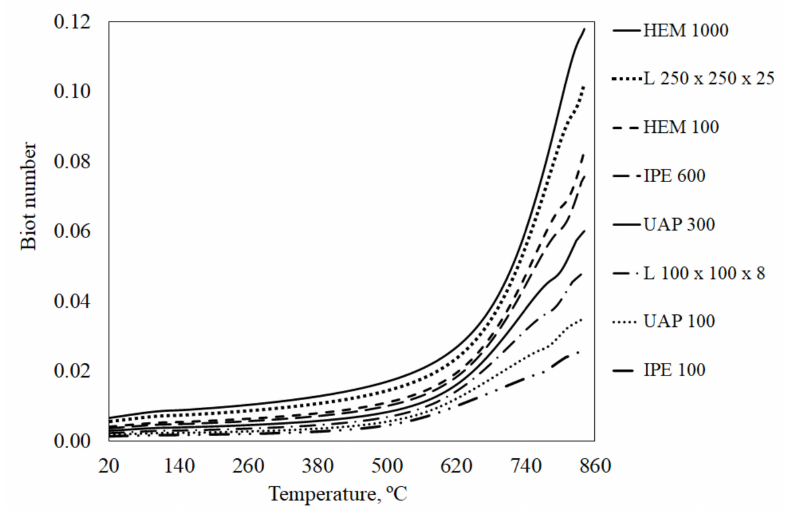
Figure 5. The Biot number.